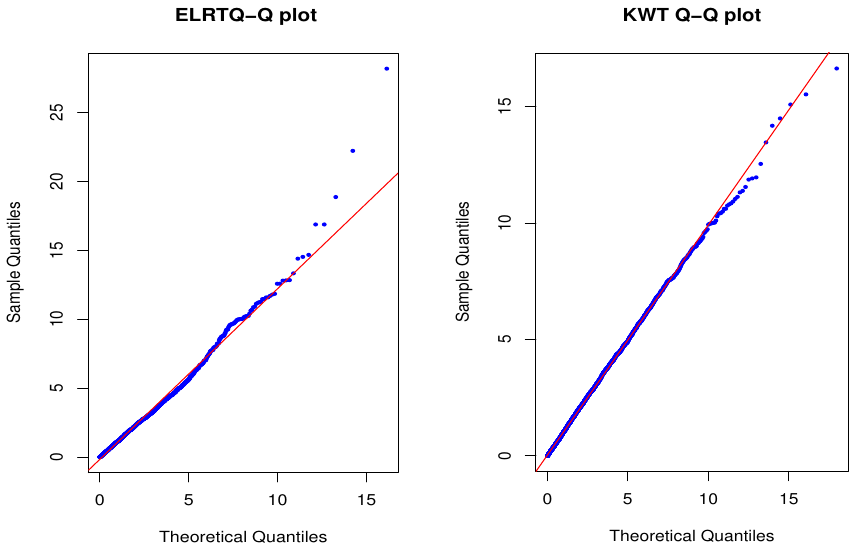
Figure 3. θ 0 = 1, the sample size is (30,30,40), the Q-Q plots of ELRT and KWT for the overall comparison of the 3 exponential